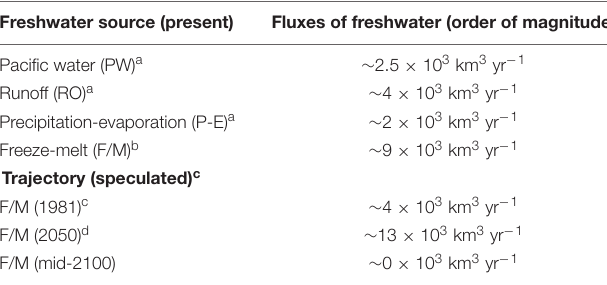
TABLE 1 | Freshwater fluxes to the Arctic Ocean, shown in Figure 2 . Freshwater source (present) Fluxes of freshwater (order of